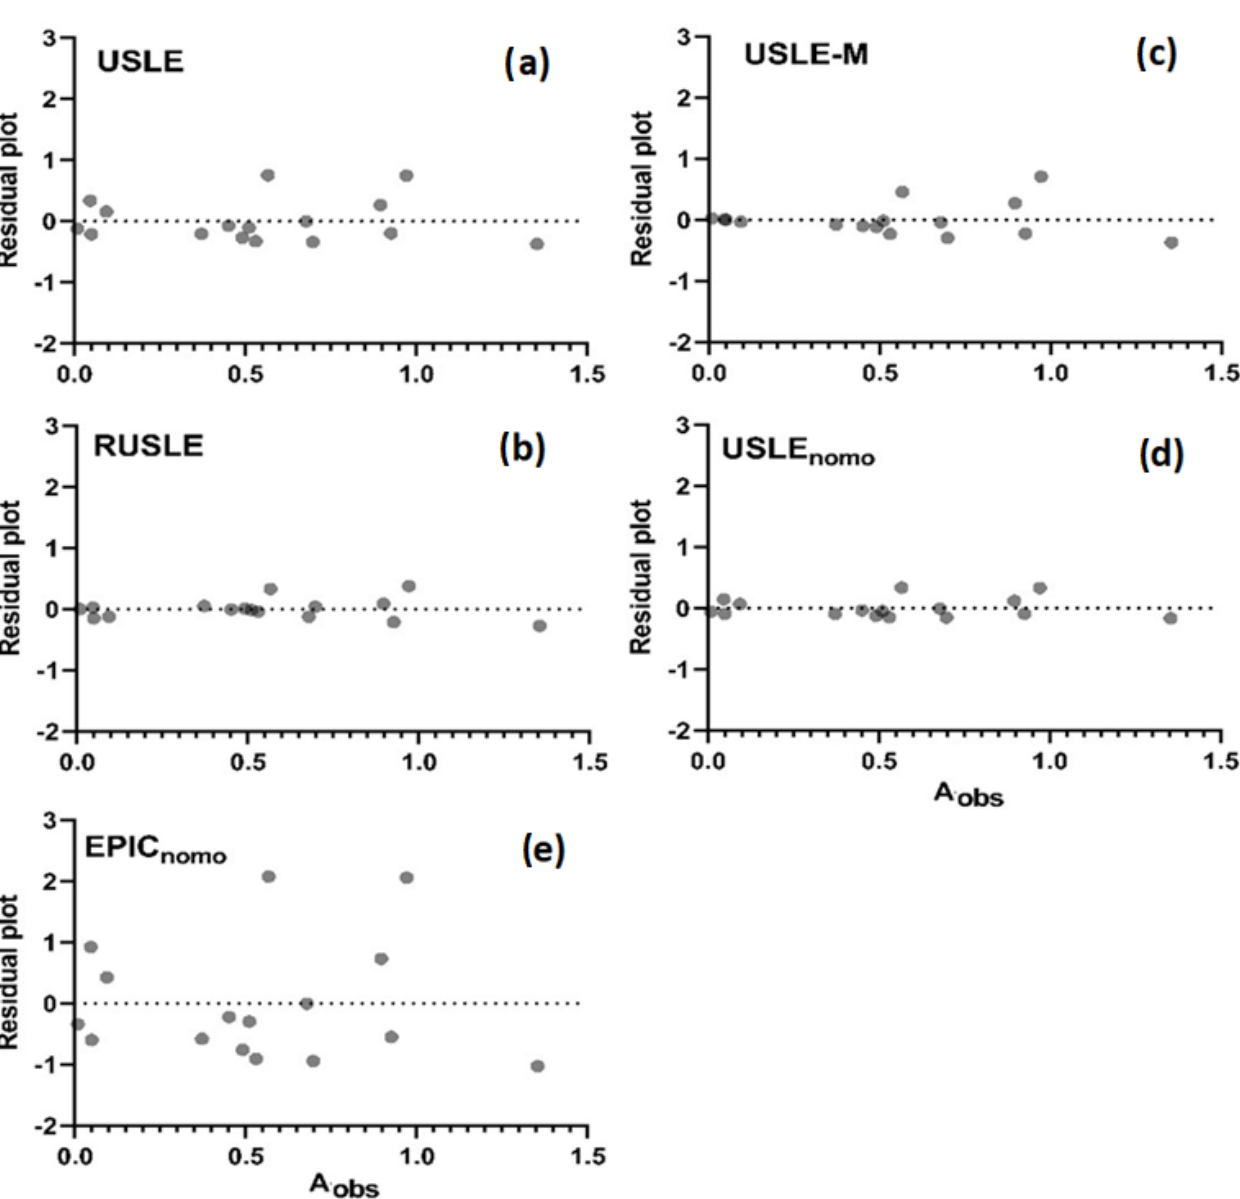
Figure 5. Predicted soil loss (from dry, moist and wet rainfall simulation treatments) plotted against residual values (measured– predicted soil loss): ( a ) USLE ( b ) RUSLE, ( c ) USLE-M, ( d ) USLE nomograph equation, ( e ) EPIC nomograph